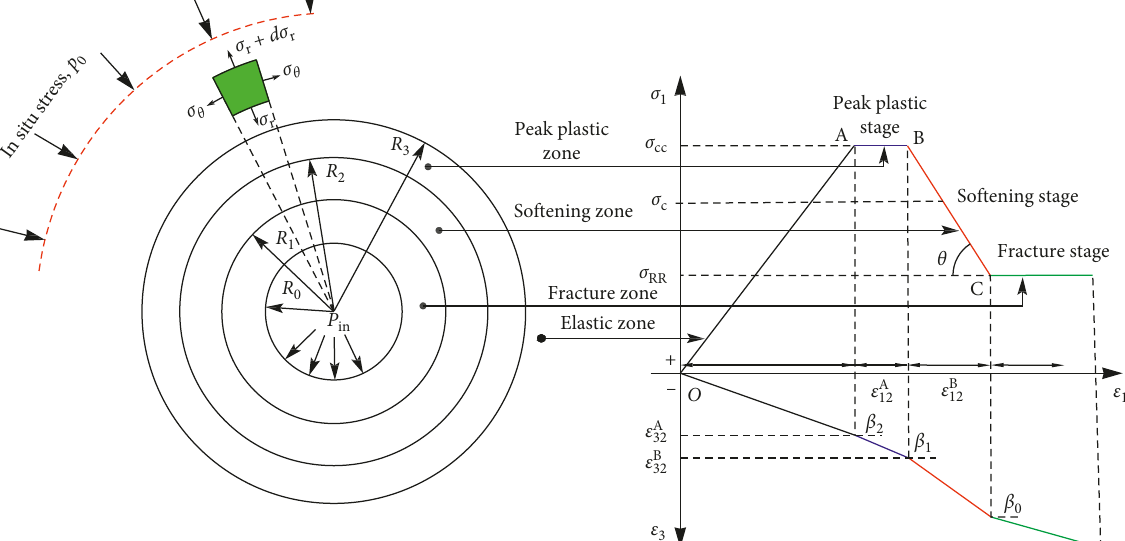
and ε A are, respectively, the maximum and minimum principal strains at 12 32